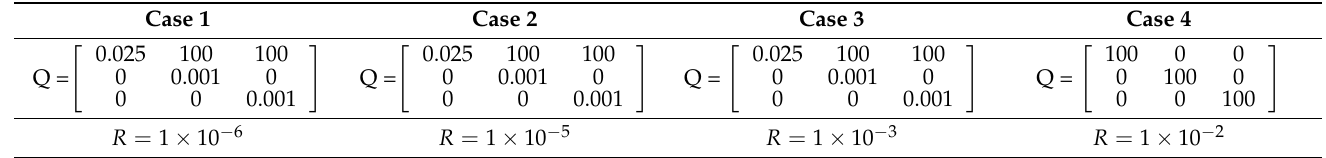
Table 3. Four controller cases with different Q and R values.